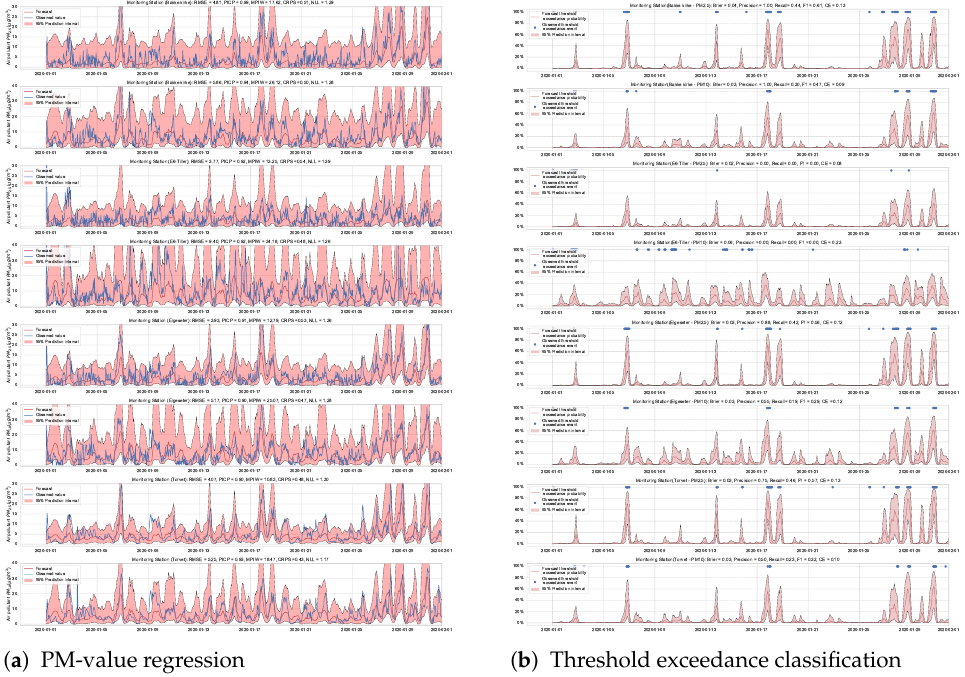
Figure A9. Deep probabilistic forecast of air quality using BNNs at four monitoring stations.